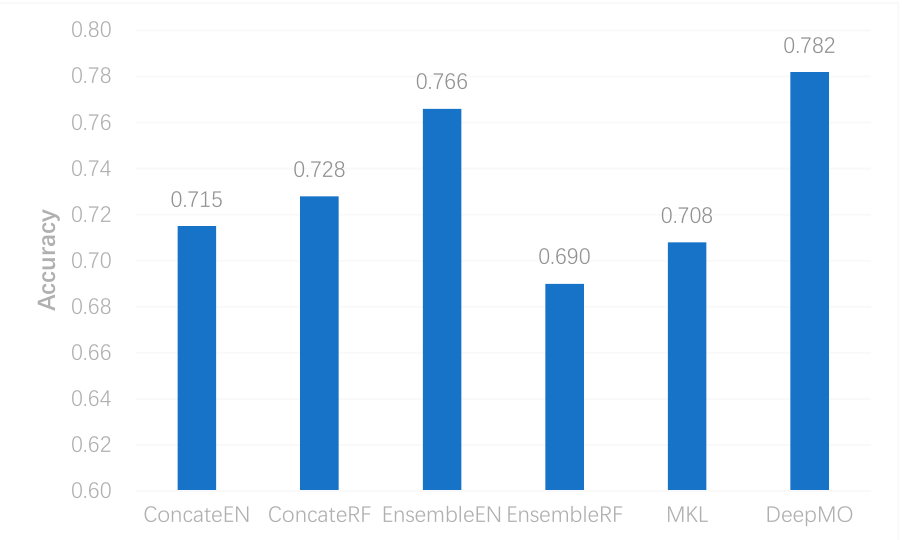
Figure 6. The accuracy of multi-classification using different methods.